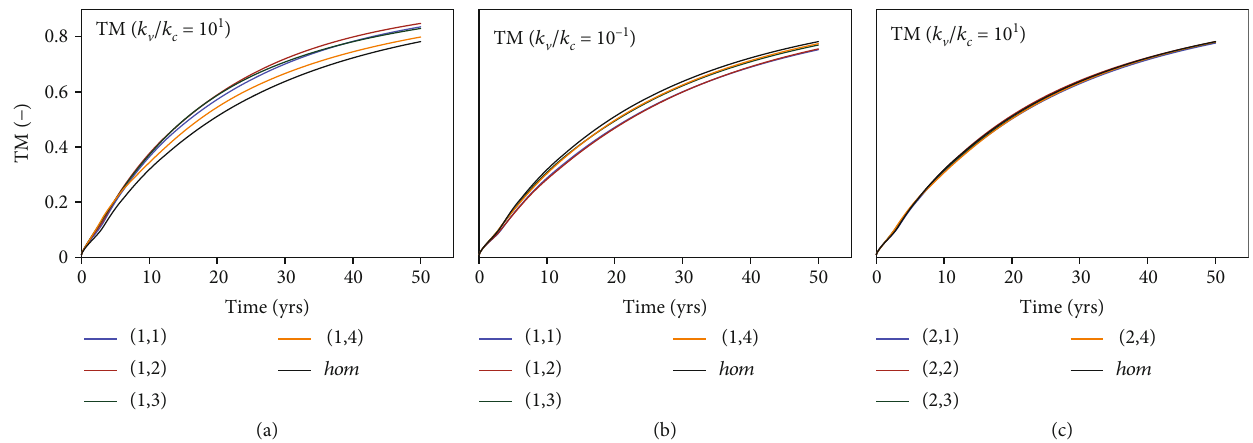
Figure 6: The calculated time-variable total solute mass (TM) for simulation cases with di ff erent permeability contrasts and locations.